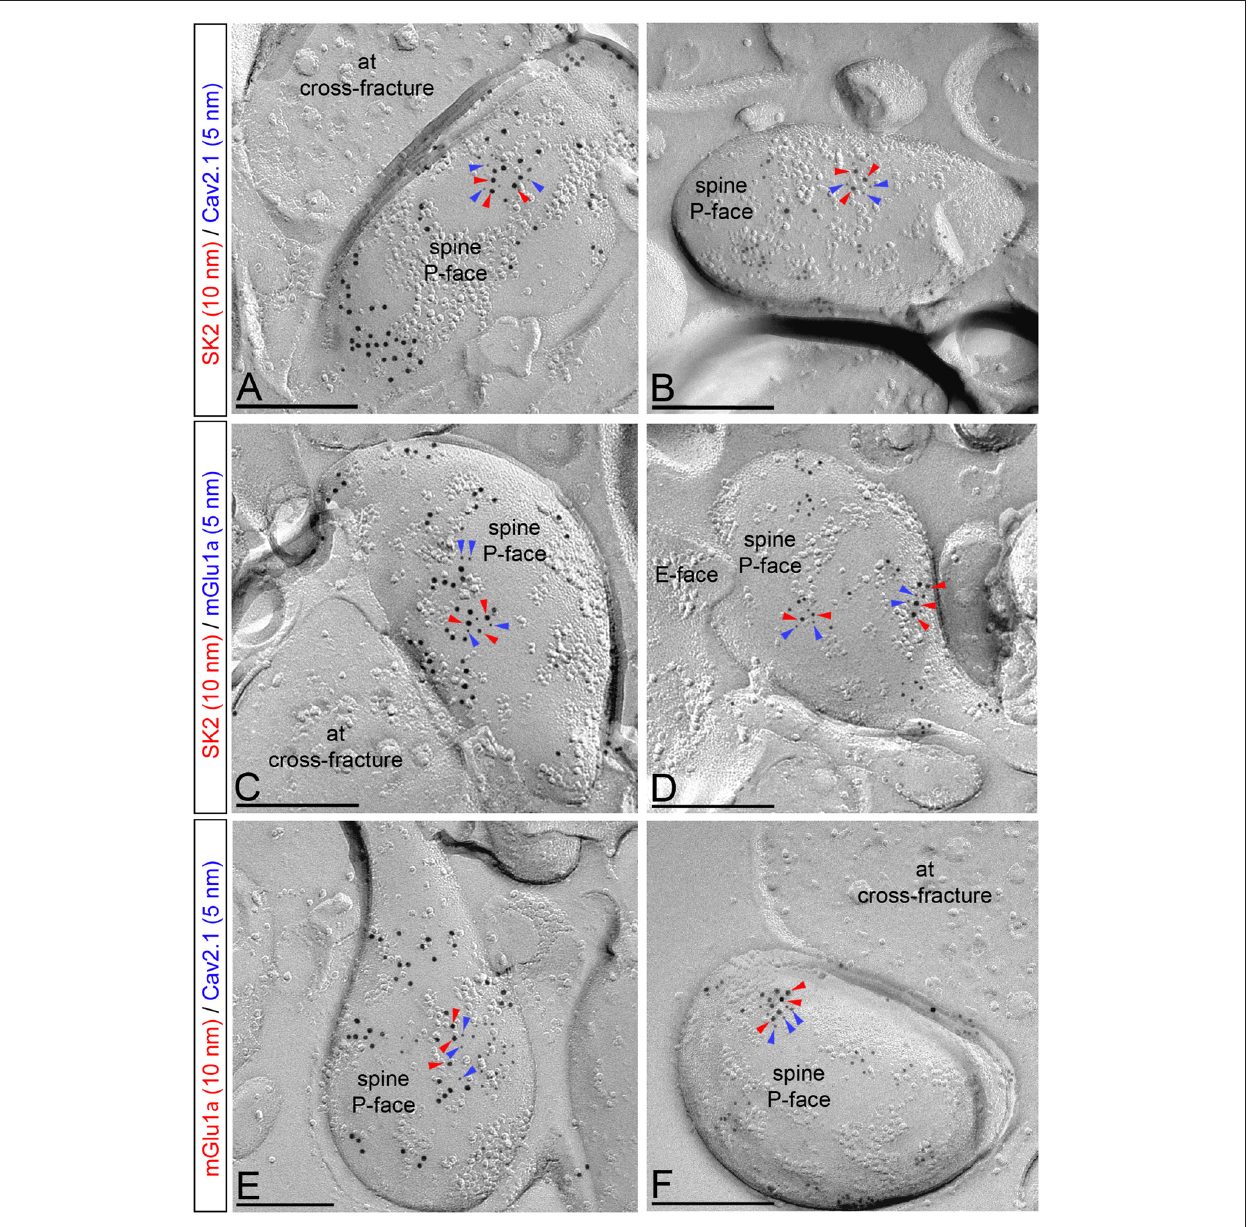
FIGURE 5 | Co-localization of SK2 channels with Ca V 2.1 channels and mGlu 1 α receptor in PC spines. Electron micrographs obtained in the molecular layer of the cerebellar cortex showing double labeling for SK2 (10 nm, red arrowheads) and Ca V 2.1 (5 nm, blue arrowheads; panels A,B ), double labeling for SK2 (10 nm, red arrowheads) and mGlu 1 α (5 nm, blue arrowheads; panels C,D ), and double labeling for mGlu 1 α (10 nm, red arrowheads) and Ca V 2.1 (5 nm, blue arrowheads; panels E,F ). In dendritic spines of PCs, SK2 immunoparticles (red arrowheads) co-clustered with those for Ca V 2.1 and mGlu 1 α (blue arrows). In addition, mGlu 1 α immunoparticles (red arrowheads) co-clustered with those for Ca V 2.1 (blue arrowheads). at, axon terminals. Scale bars: (A–F) 0.2 µ m.